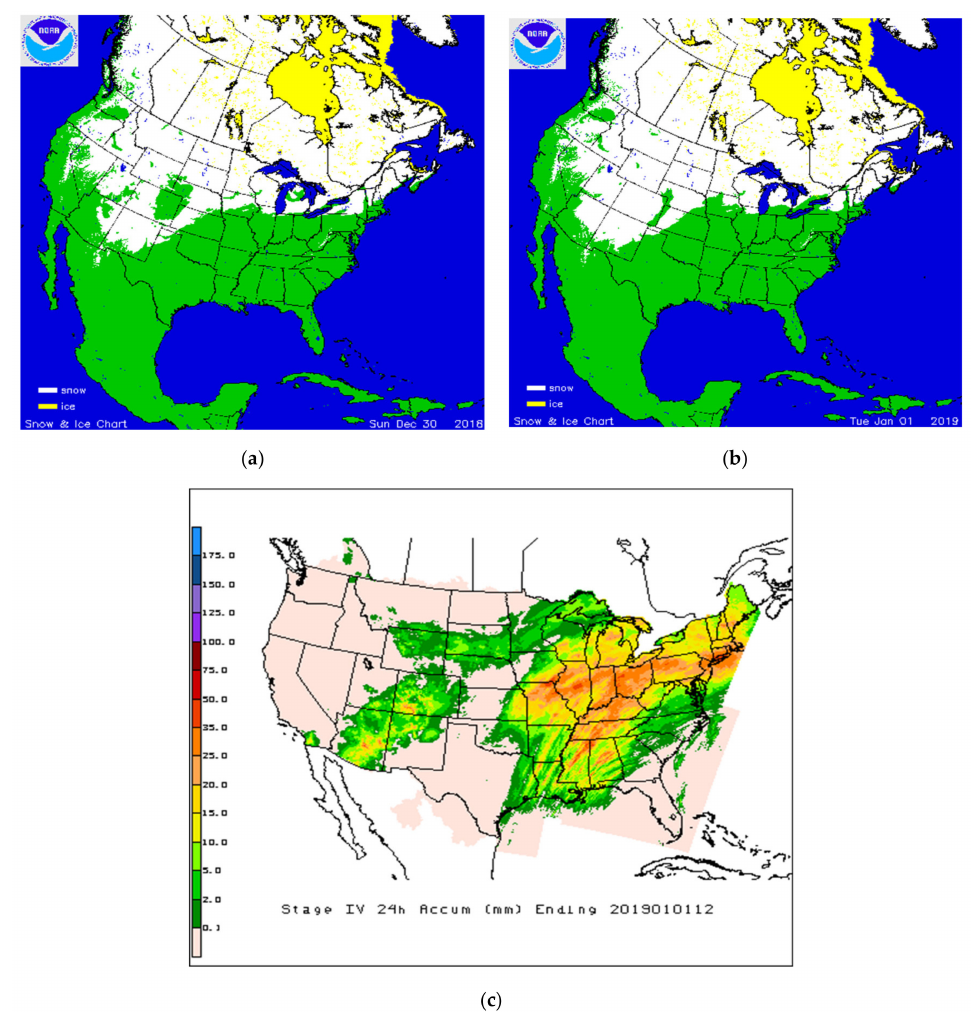
Figure 4. IMS snow maps on ( a ) 30 December 2018 and ( b ) 1 January 2019, respectively, and ( c ) NCEP Stage IV Multi-Sensor 24 h precipitation accumulation ending 1 January 2019 12 Zulu